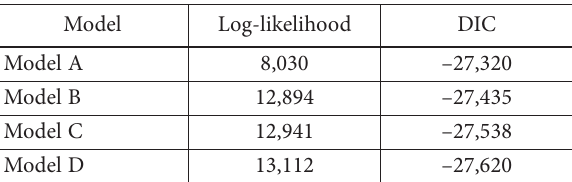
Table 3. Comparison of candidate models